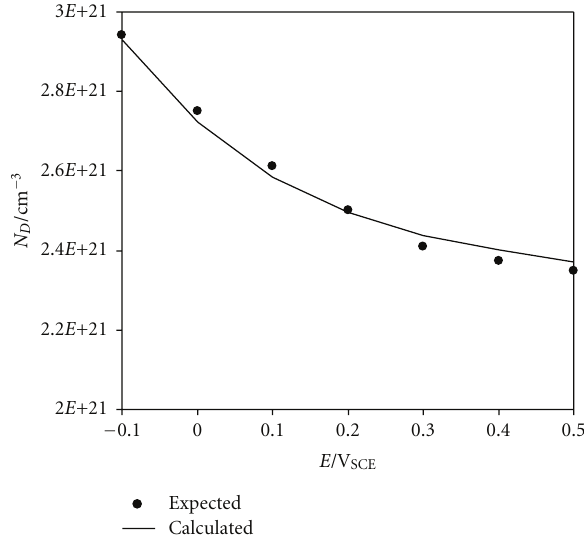
Figure 6: Curve of donor density as function of film formation potential of the passive films formed on 316 in 0.05M H 2 SO 4